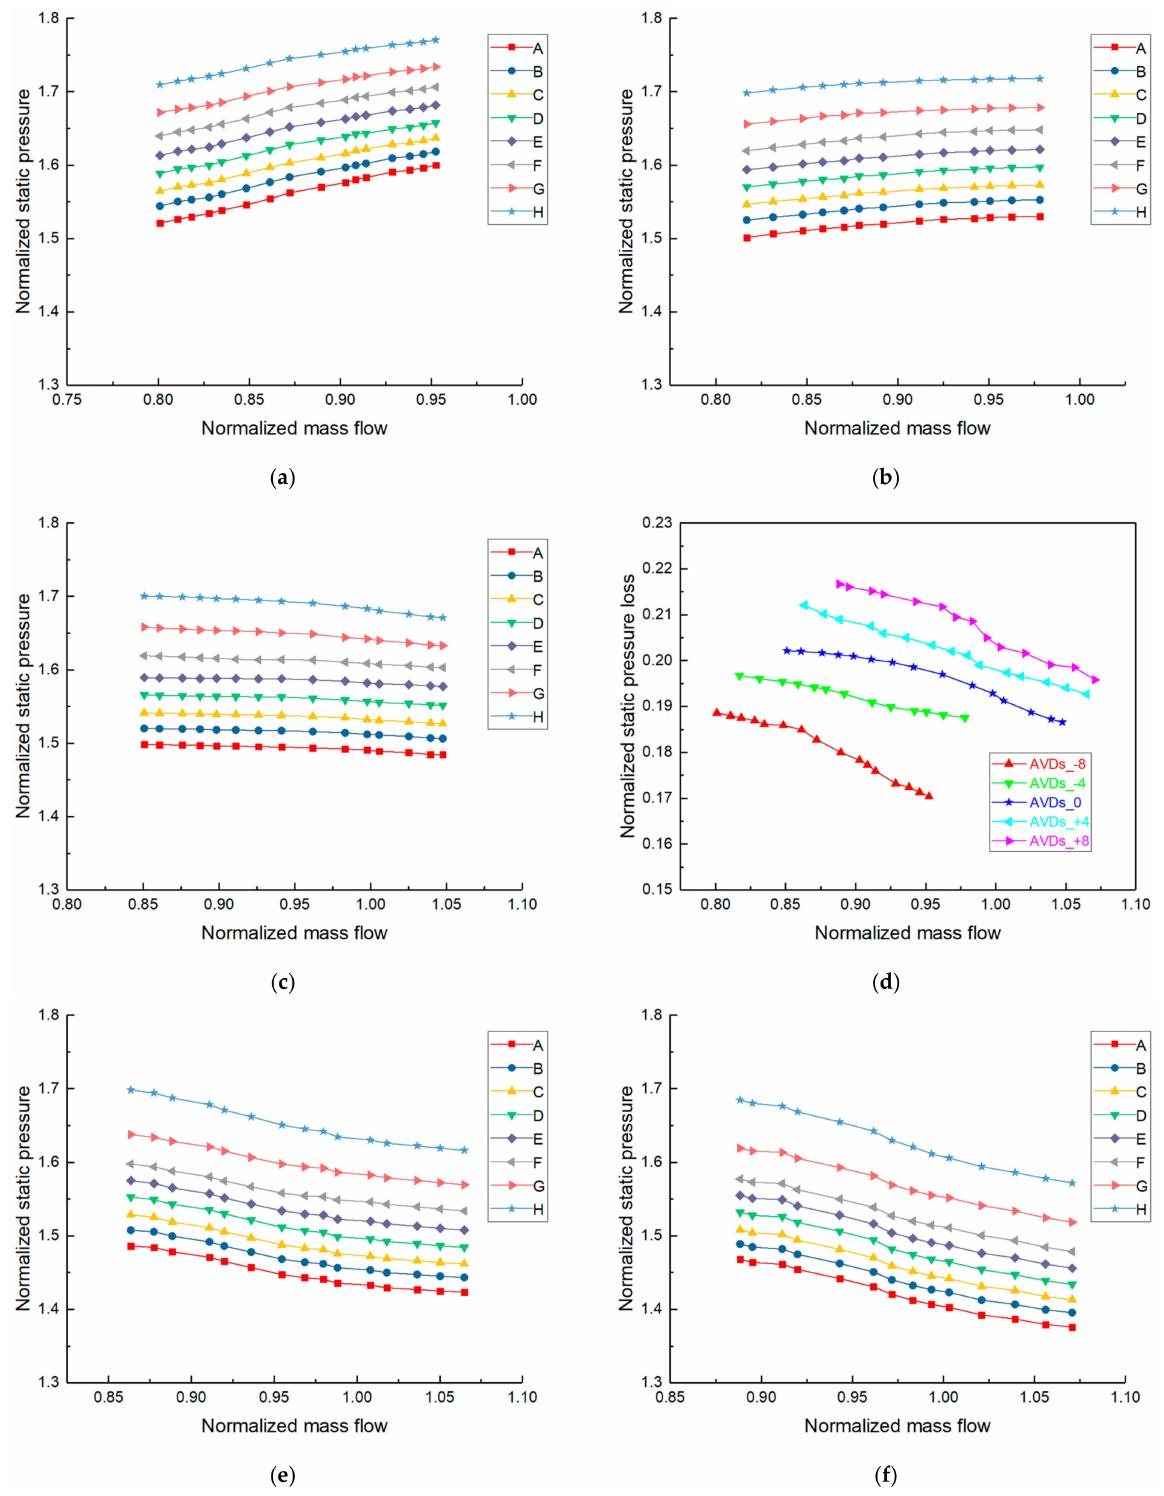
Figure 9. Characteristic curves of static pressure and its loss on the static wall of IBC under variable AVDs’ angles: ( a ) static pressure with − 8 ◦ AVDs; ( b ) static pressure with − 4 ◦ AVDs; ( c ) static pressure with 0 ◦ AVDs; ( d ) static pressure loss with variable AVDs’ angles; ( e ) static pressure with +4 ◦ AVDs; ( f ) static pressure with +8 ◦